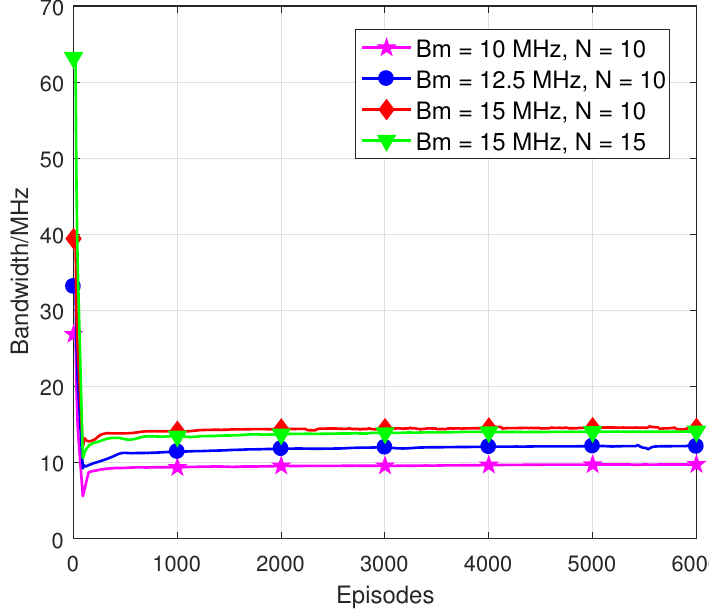
Figure 5. Total bandwidth allocated for all devices during training